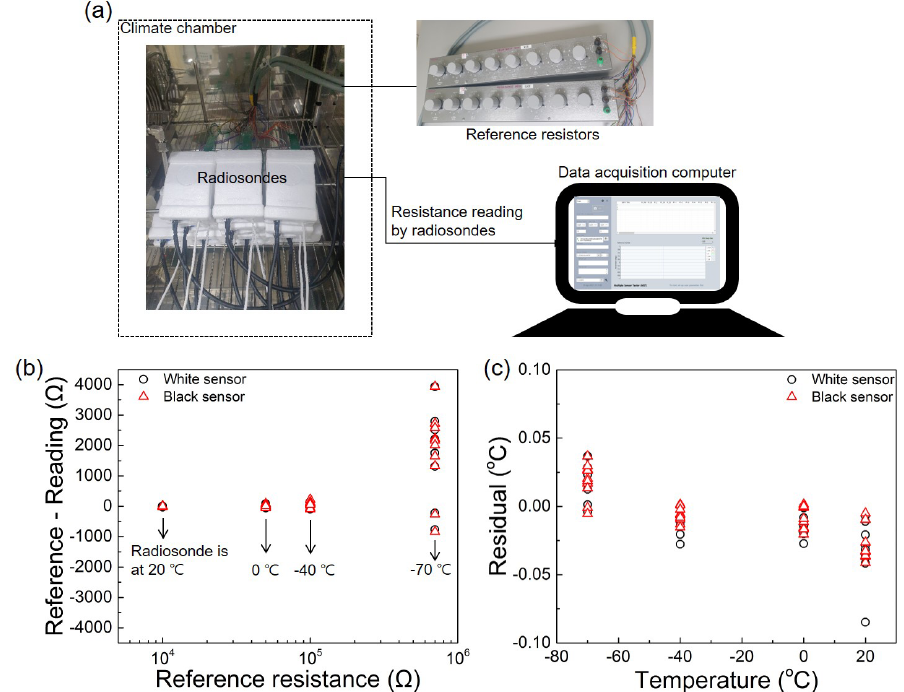
Figure 4. Test of the temperature effect on resistance reading by radiosonde boards. (a) Test setup showing the radiosonde boards in a climate chamber (left), reference resistors (top right) and a data acquisition computer (bottom right). (b) Difference between the reference resistance and radiosonde reading as a function of the reference resistance. (c) Residual after conversion of resistance to temperature as a function of